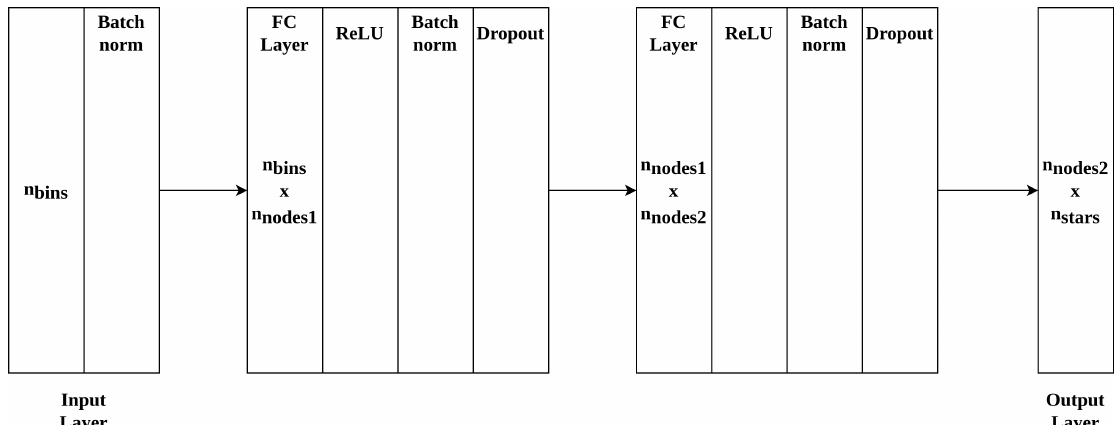
Figure 2. Proposed neural network for lost-in-space star identification. Layer sizes are variable and dependant on application environment.